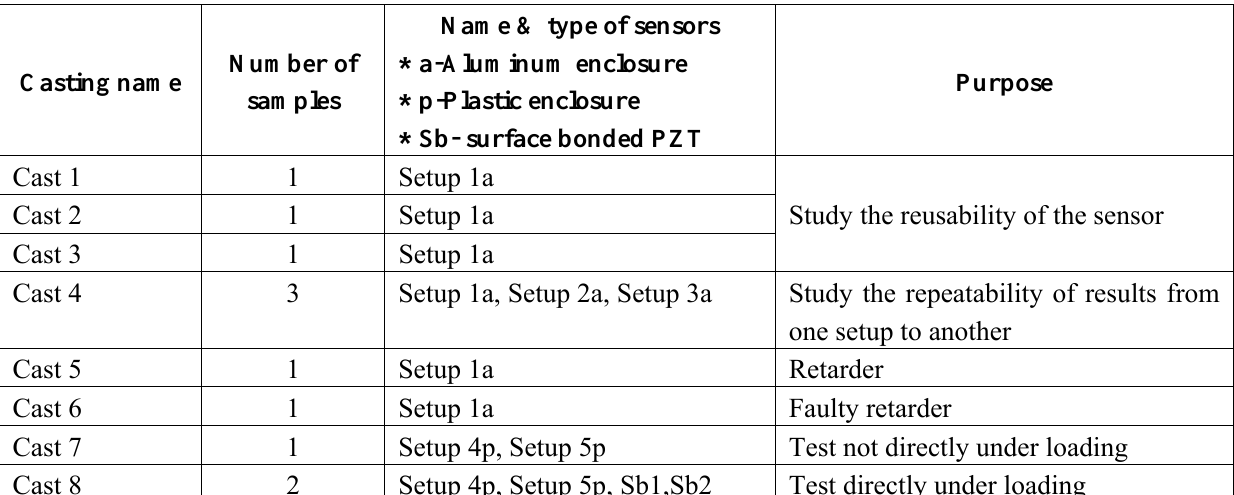
Table 1. Summary of experimental